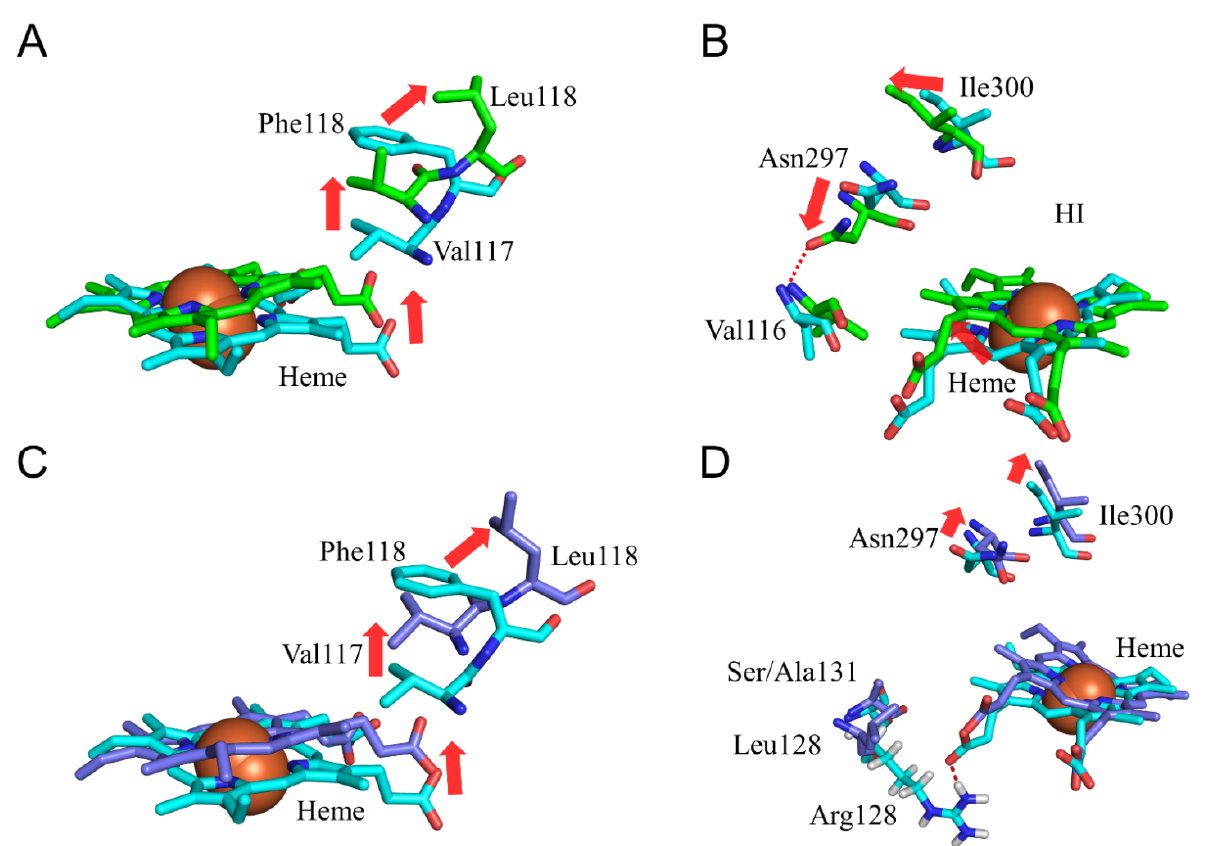
Table 6. Hydrogen bond formation involved in the structural change in CYP2A6.25 and CYP2A6.26.